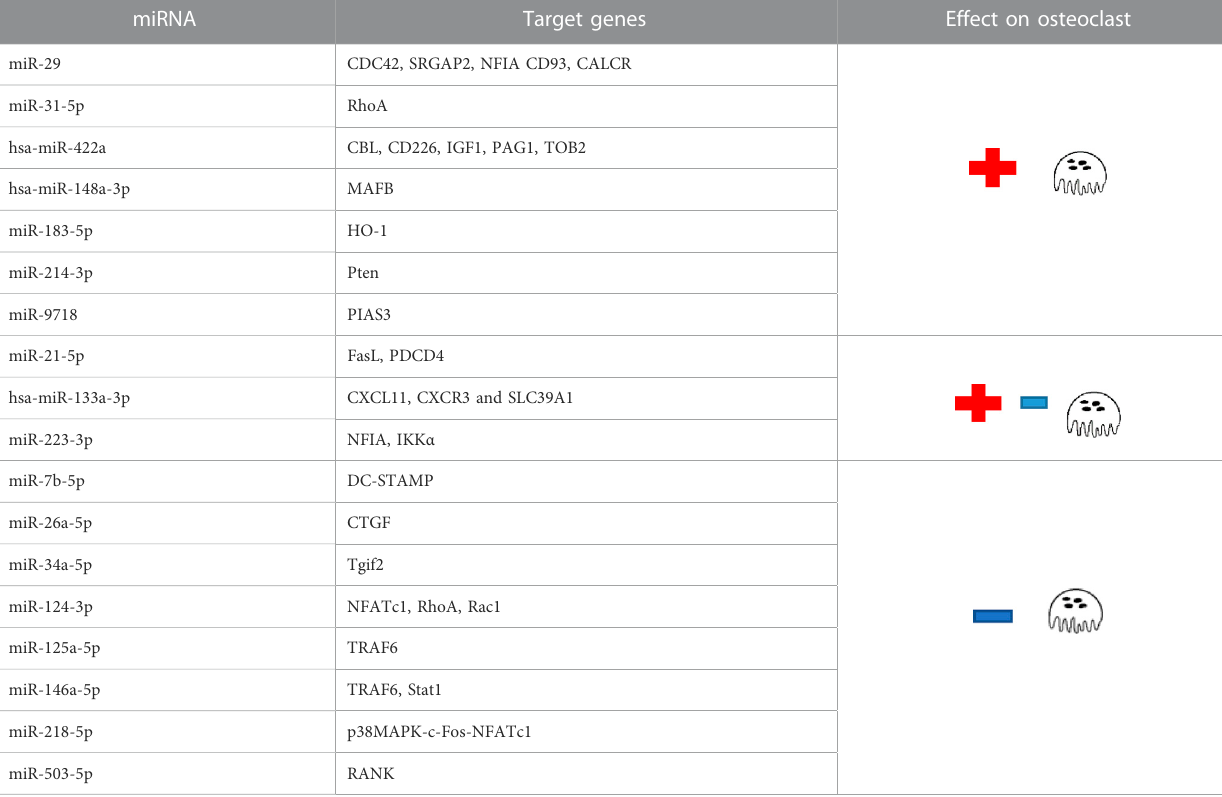
TABLE 1 miRNAs that promote and/or inhibit the osteoclasts. miRNA Target genes Effect on osteoclast miR-29 CDC42, SRGAP2, NFIA CD93,